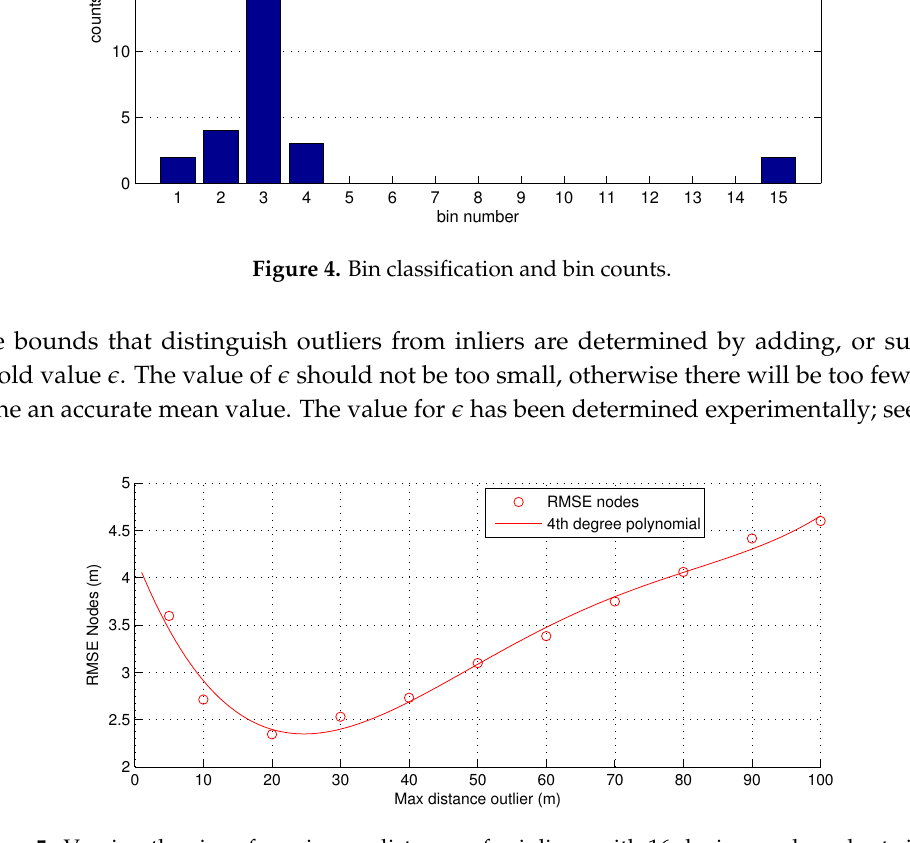
Figure 5. Varying the size of maximum distance (cid:101) for inliers, with 16 devices and a subset size of 10